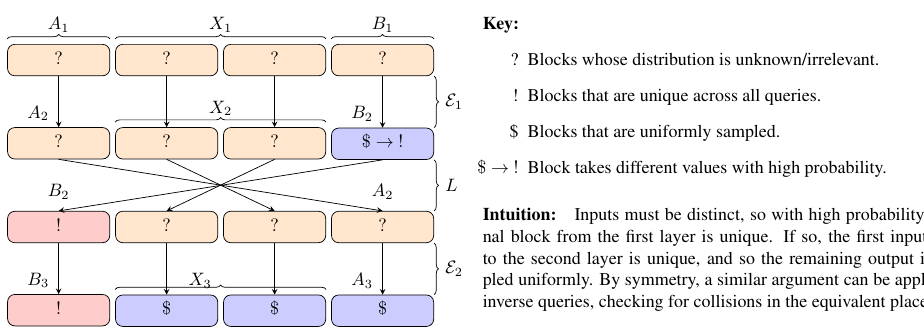
Figure 11: Intuition behind the AIL- ± prp security of Π rev of an Online-but-last scheme (Theorem